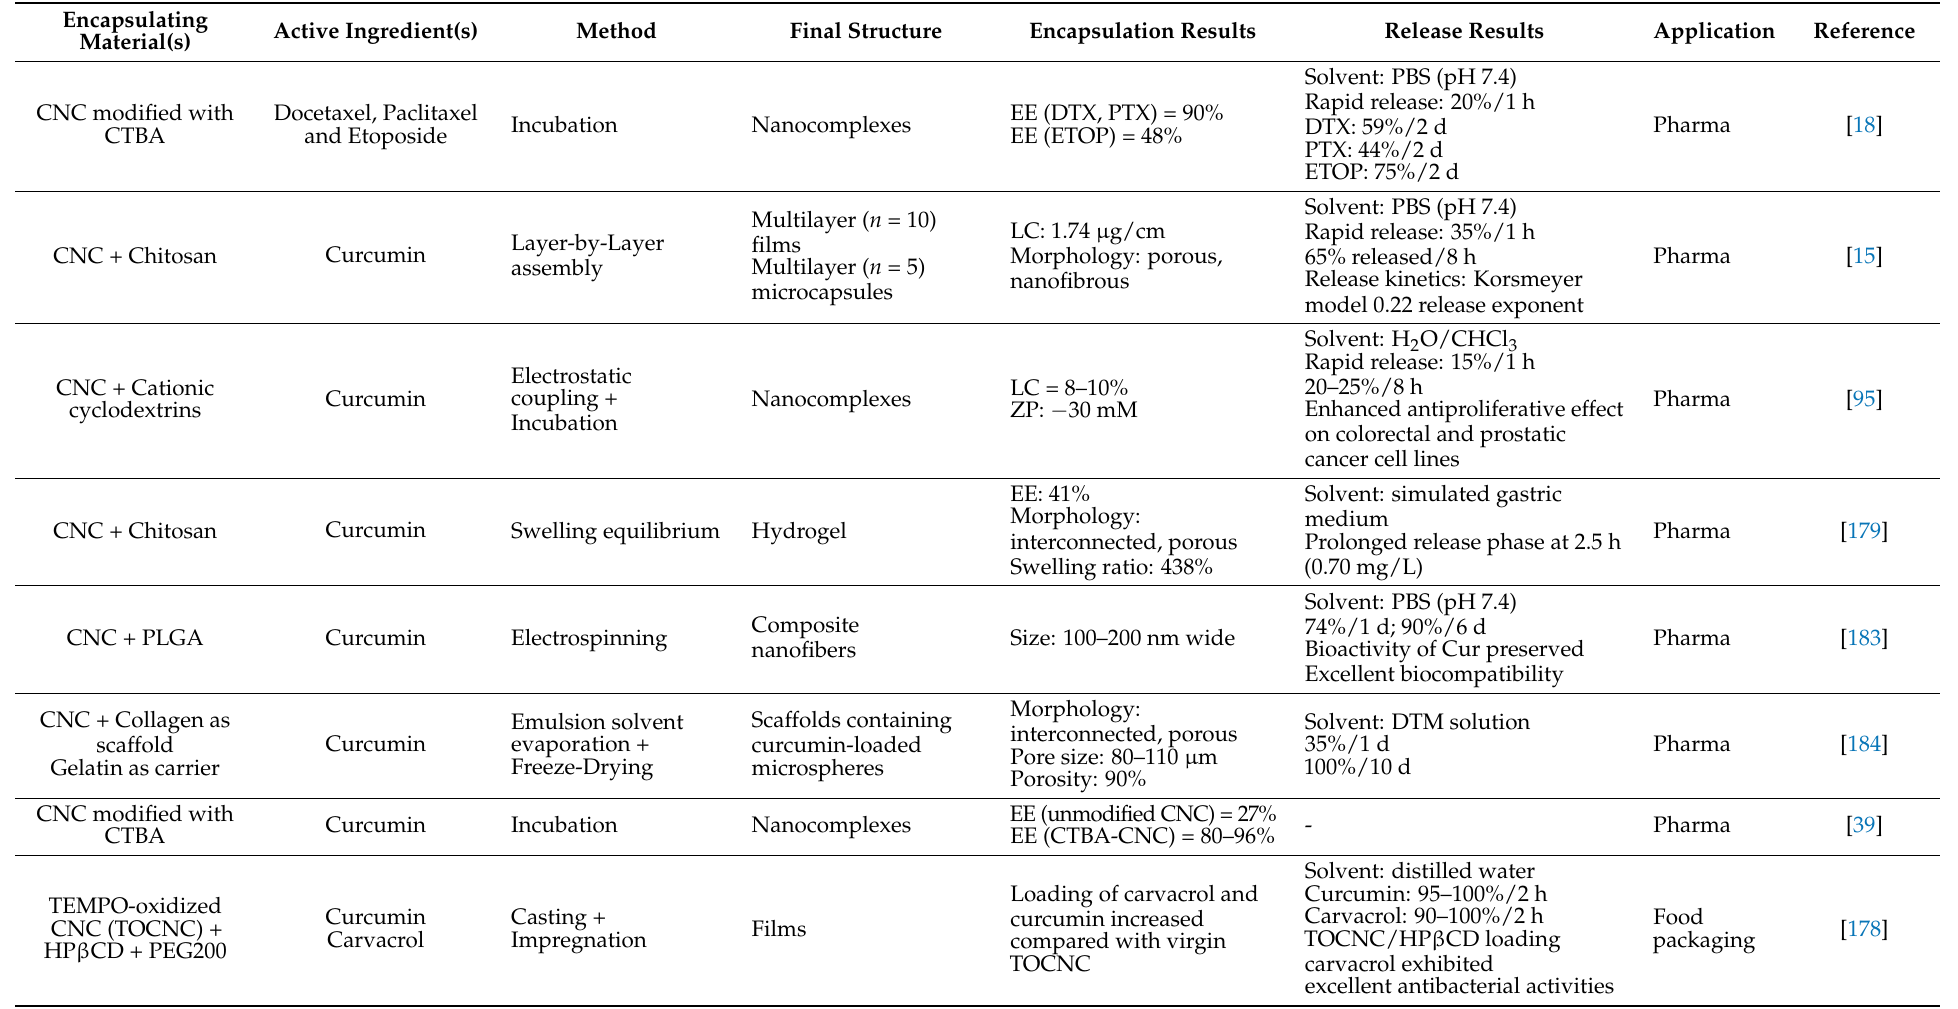
Table 3. Studies on the use of cellulose nanocrystals for the encapsulation and controlled release of liposoluble